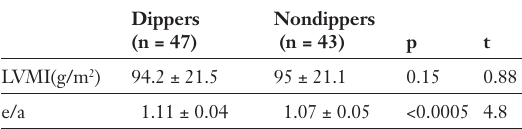
Echocardiographic findings in dippers and